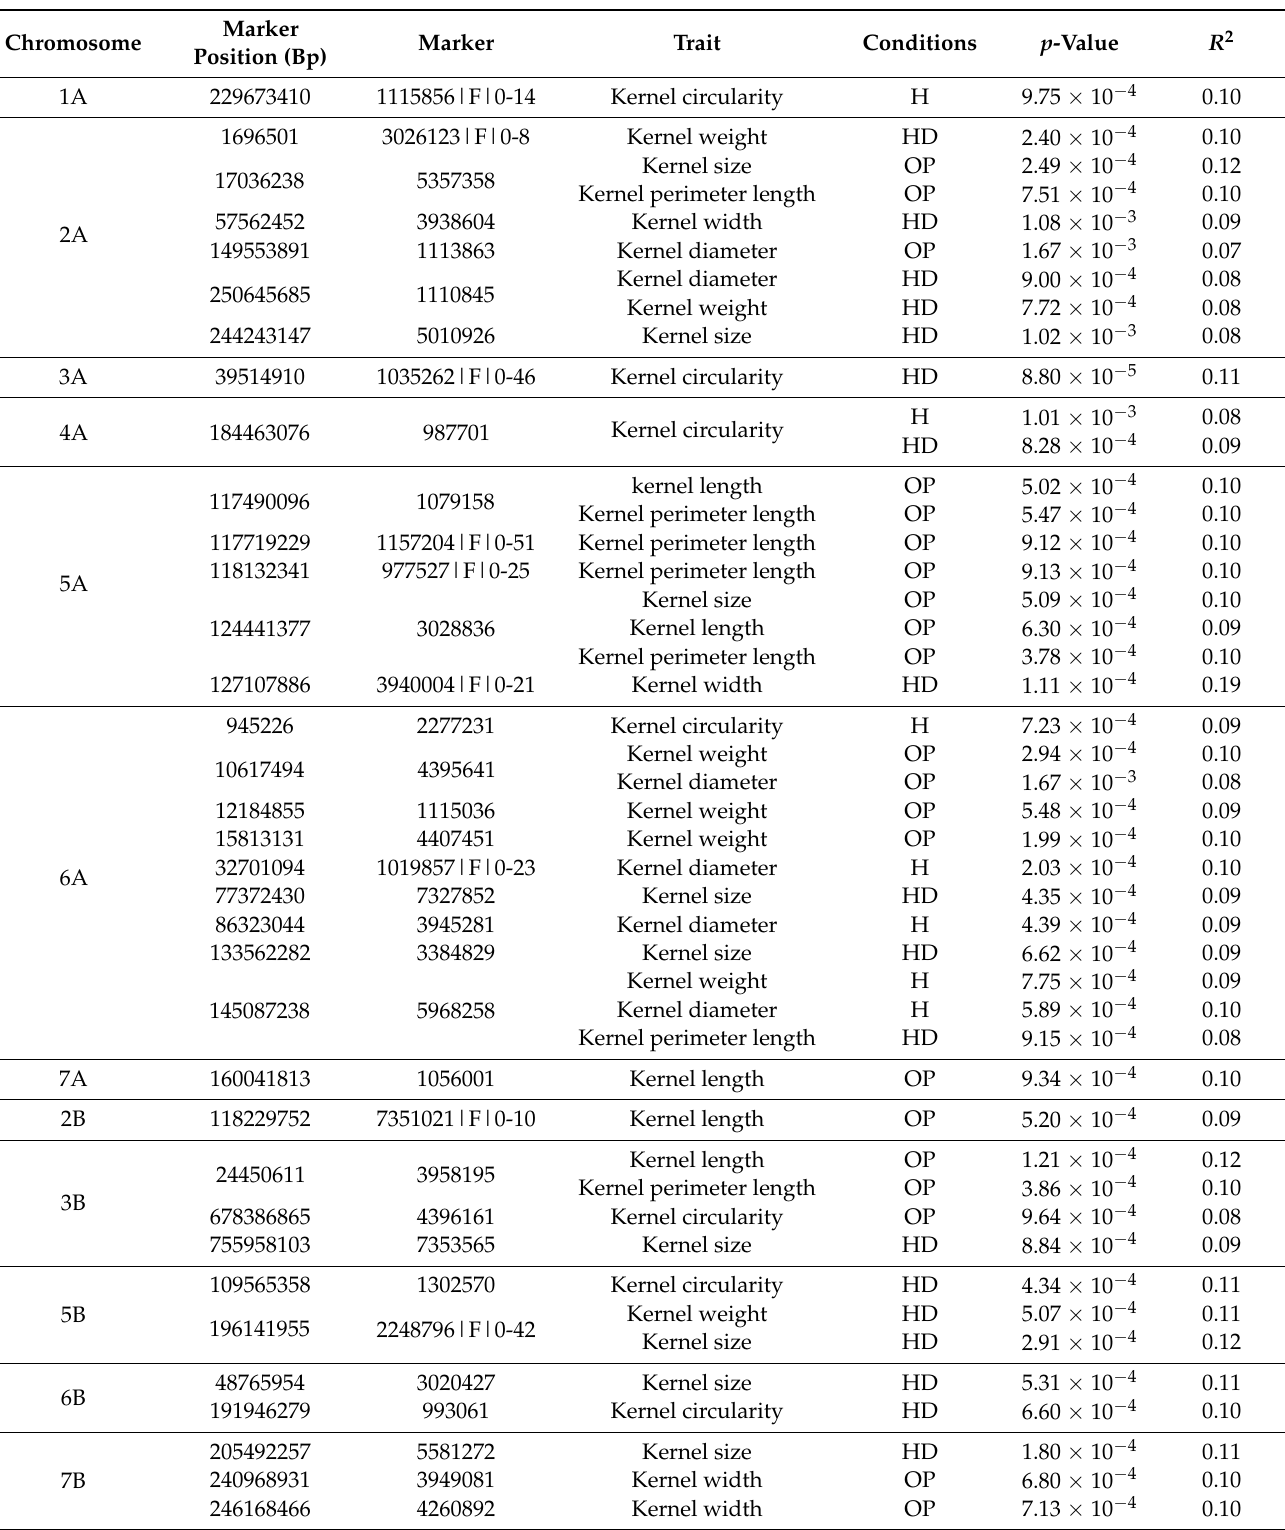
Table 2. Marker trait associations of kernel weight and shape-related traits in multiple synthetic derivative lines grown under optimum (OP), heat (H) and combined heat–drought (HD)